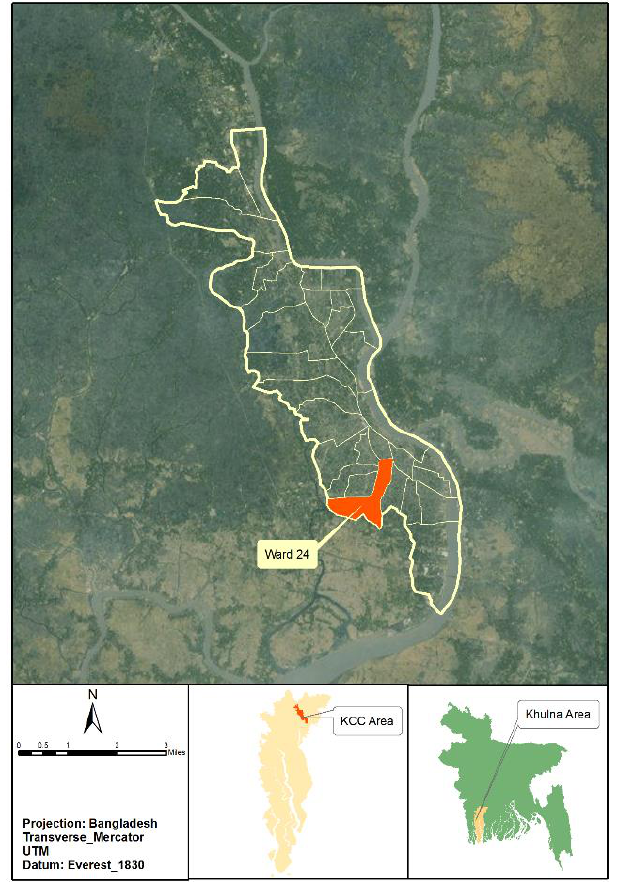
Figure 1. Maps of Study Area.